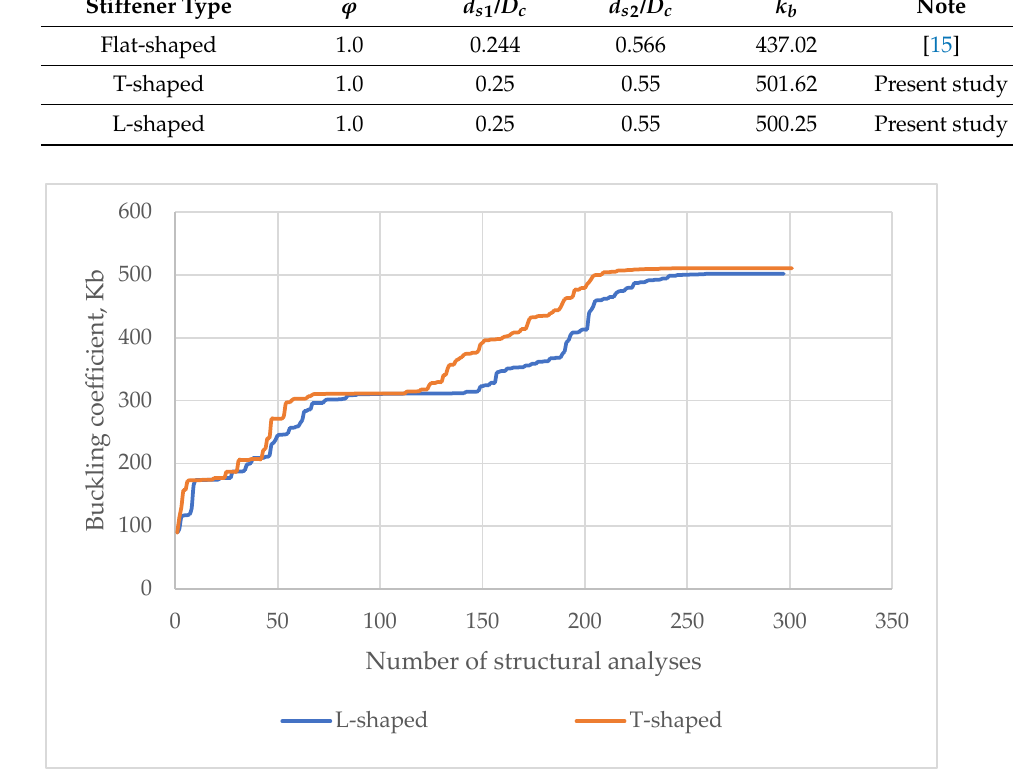
Figure 5. Convergence history for stiffeners with open cross-section shapes.